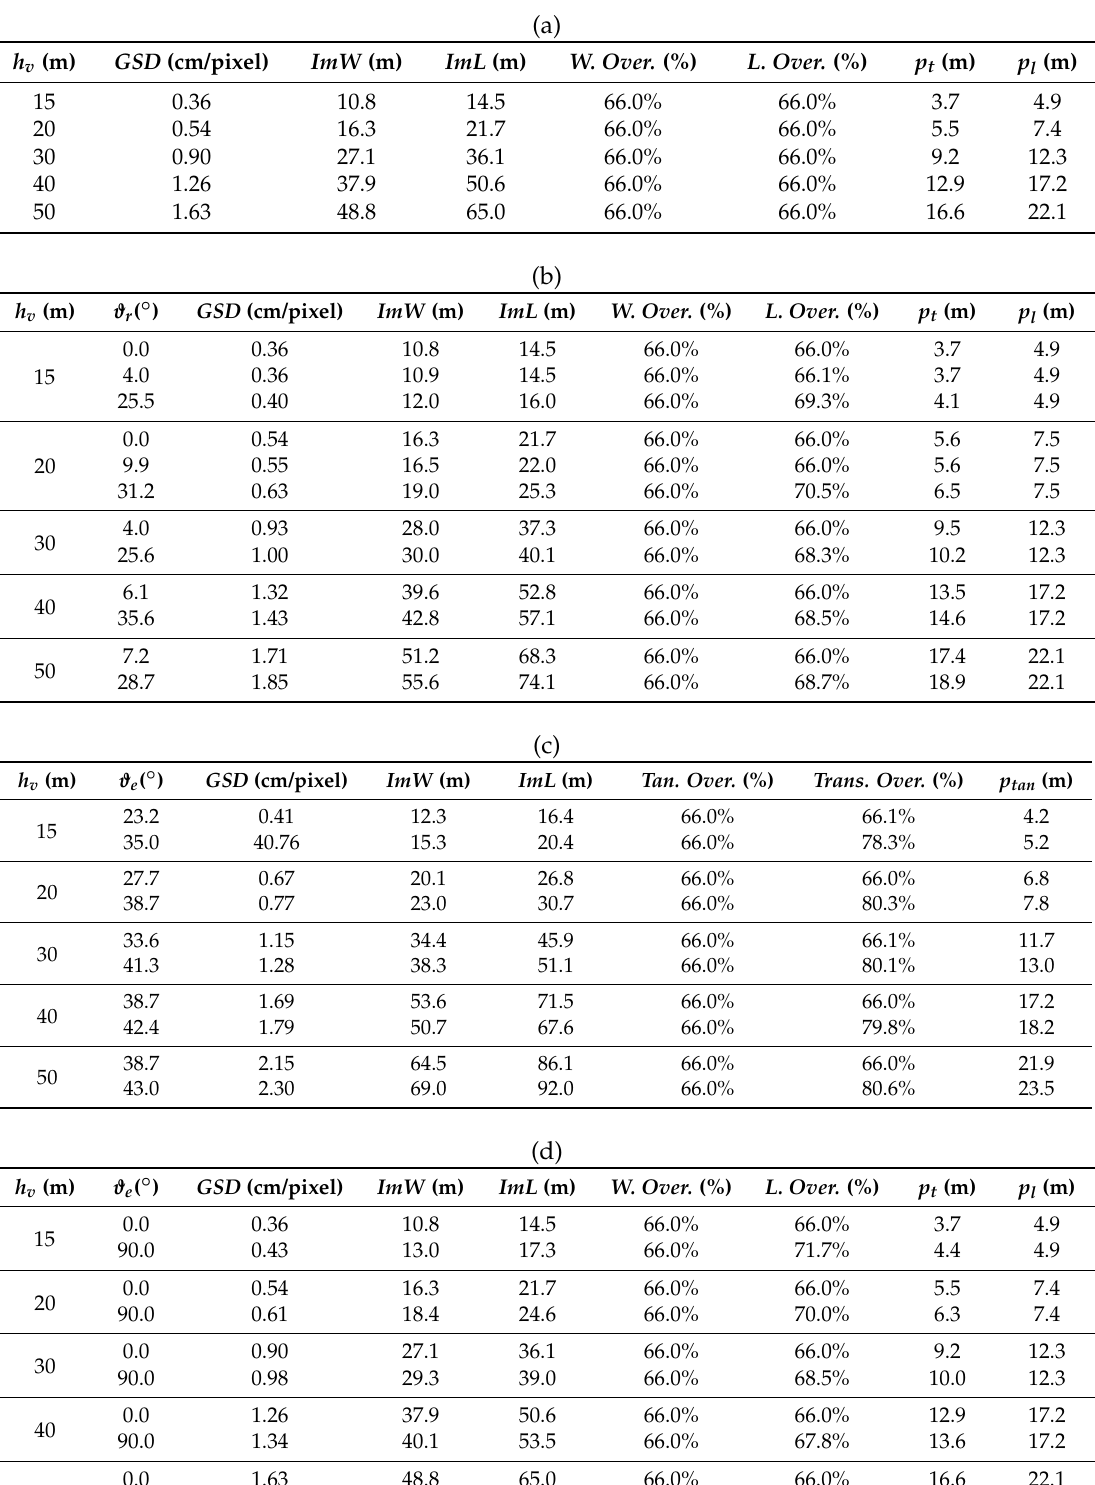
Table 3. (a) GSD , overlaps, and pitches in RGVC; (b) GSD , overlaps, and pitches in RGOC; (c) GSD , overlaps, and pitches in EG; (d) GSD , overlaps, and pitches in